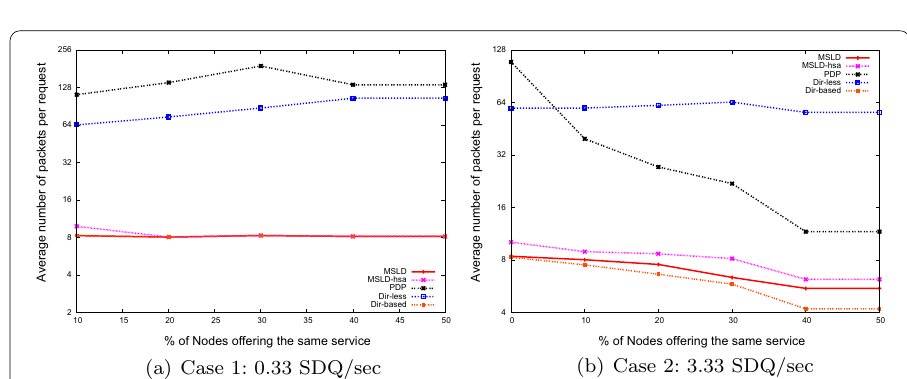
Fig. 4 Services reliability versus Overhead. Figure shows the message overhead of all four protocols under study. These results were collected when increasing the percentage of servers offering the same service from 5 to 50 for low and high SDQ rates. For low rates of SDQ messages, a variation of N srv does not seem to have a major impact on the MSLD protocol running in a unicast mode and the Dir‑based protocol. On the other hand, the N srv seems to have an impact on the number of control messages since all servers having the requested service are expected to respond with an SDY messages for every service request being originated leading to more overhead as N srv increases. Same behavior is witnessed for PDP except the case where the cache has information about the requested service and only devices with higher energy may respond on behalf of low‑energy nodes. Conversely, at higher SDQ rates, when the number of servers offering a similar service increases, there will be a higher chance of re‑requesting the same service, and hence message overhead decreases because of higher cache hits. PDP has maximum performance gain because of SDY broadcasts, which well‑populate node